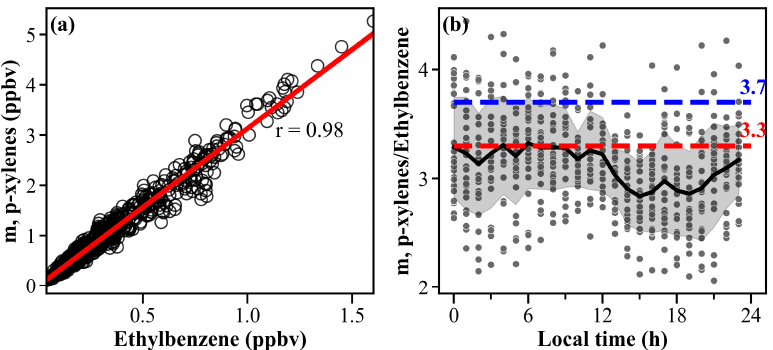
Figure 2. Scatterplot of measured m, p-xylene with ethylbenzene ( a ) and diurnal variation of the m, p-xylene/ethylbenzene ratios ( b ). The red dashed line represents the m, p-xylene/ethylbenzene initial emission ratio estimated by the regression of nighttime concentrations; the blue dashed line represents the initial ratio estimated by the 90th percentile method. The black line and grey areas are the mean and standard deviation, respectively.